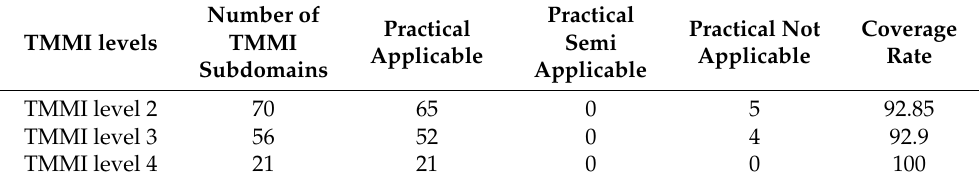
Table 3. Addressing TMMI levels with Agile